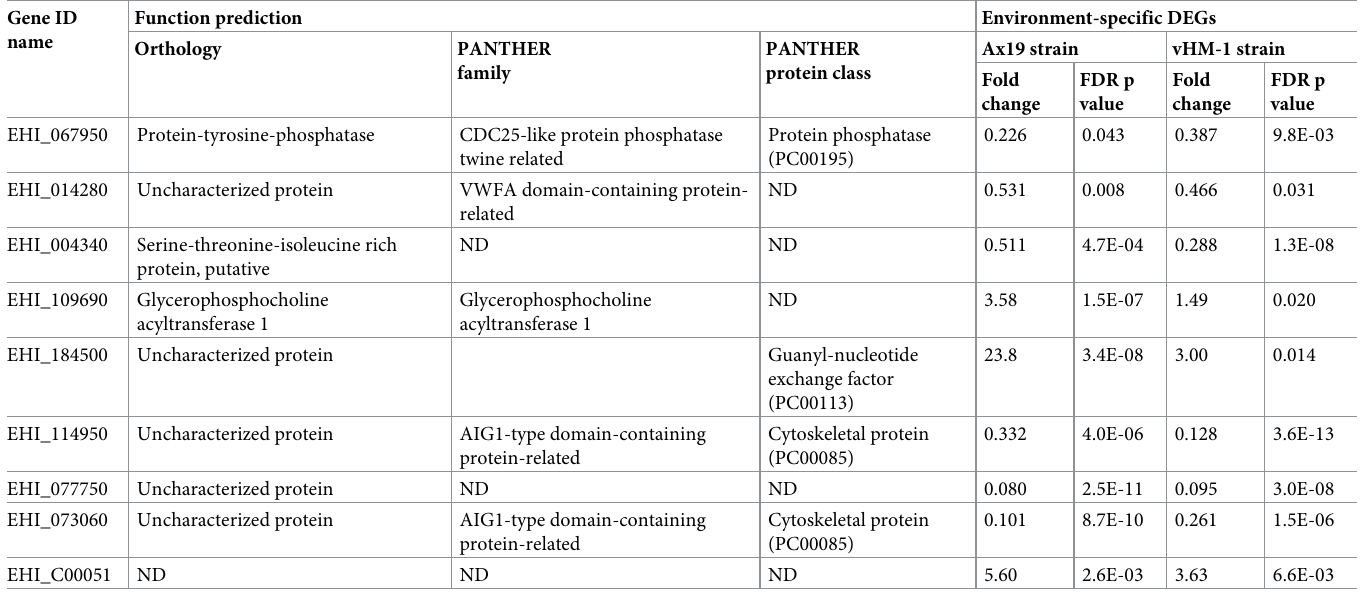
Table 3. Orthologous lists of the nine genes that were similarly up- or down-regulated among the environment-specific DEGs of strains Ax19 and HM-1